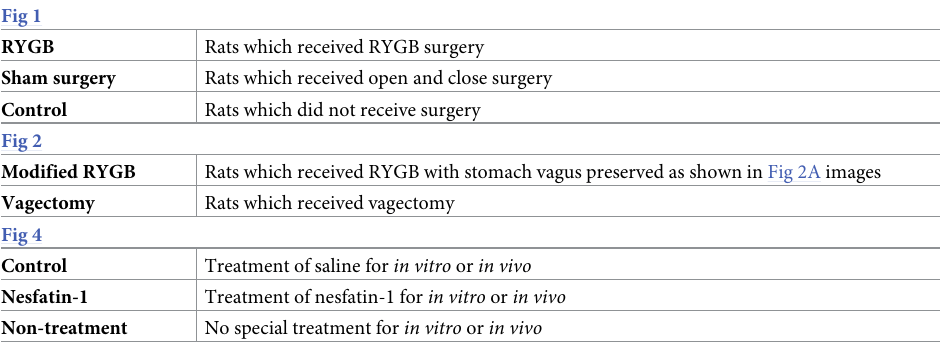
Table 1. Names and introductions of the groups and subgroups. Fig